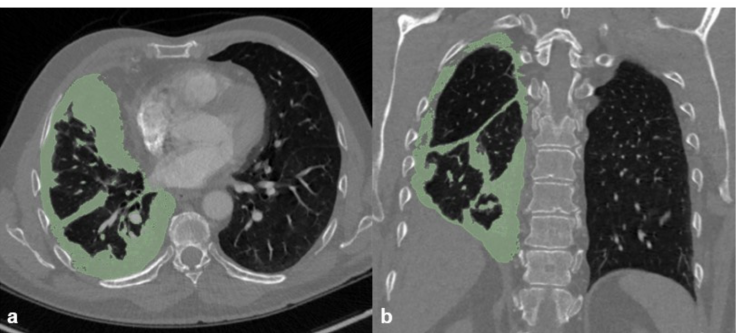
Figure 3. Morphometric measurements of tumor volume on ( a ) axial and ( b ) coronal